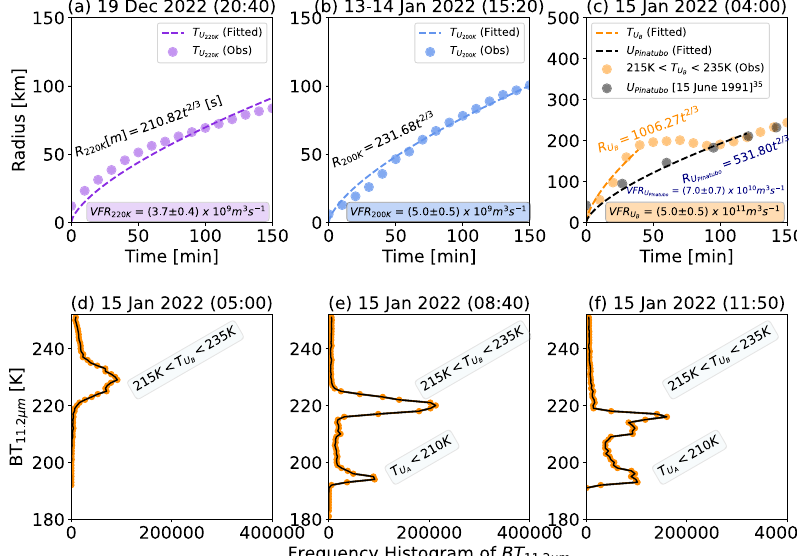
Fig. 2 The initial radial expansion of the umbrella clouds, and eventual presence of the double umbrella on 15 Jan. a On 19 December 2021 (initial eruption starts around 20:40 UTC), the radial change of umbrella height as a function of the initial 150 min is estimated at contour level 220 K using the Himawari-8 observations (T U (Obs); violet dots). The dashed purple line in panel a indicates the polynomial fi tting for the initial 150 min at contour level 220K 220 K (T (Fitted)). The R (in meter) and t (in sec) relations and volumetric fl ow rate and associated uncertainty values are described by the inset text. U 220K b Same as a but 13 – 14 January 2022 eruption time (starting around 15:20 UTC). In this case, the polynomial fi tting is performed for the 200 K BT 11.2 μ m value. The R and VFR represent the same as in a . c Same as a but for the greatest explosive eruption on 15 January 2022 starting between 04:00-04:10 UTC (true color RGB shows the initial eruption at 04:00 UTC). In panel c , the radial expansion of the umbrella with time during the climactic eruption of Pinatubo for the contour level between 220 K and 240 K was taken from Mastin 35 . d On 15 January 2022 at 05:00 UTC, the frequency histogram of BT 11.2 μ m was estimated for the entire area of Fig. 1d. At 05:00 UTC, the upper umbrella cloud (215 K < T U < 235 K) is dominant during the initial hours of B climactic eruptions on 15 Jan 2022. e The frequency histogram of BT 11.2 μ m on 15 January 2022 at 08:40 UTC, when two umbrella clouds distinctly appear (as seen in Fig. 1d). f Same as e but at 11:50 Z when climactic eruption was in declines. Processed datasets related to Fig. 2 can be found in the Supplementary Data